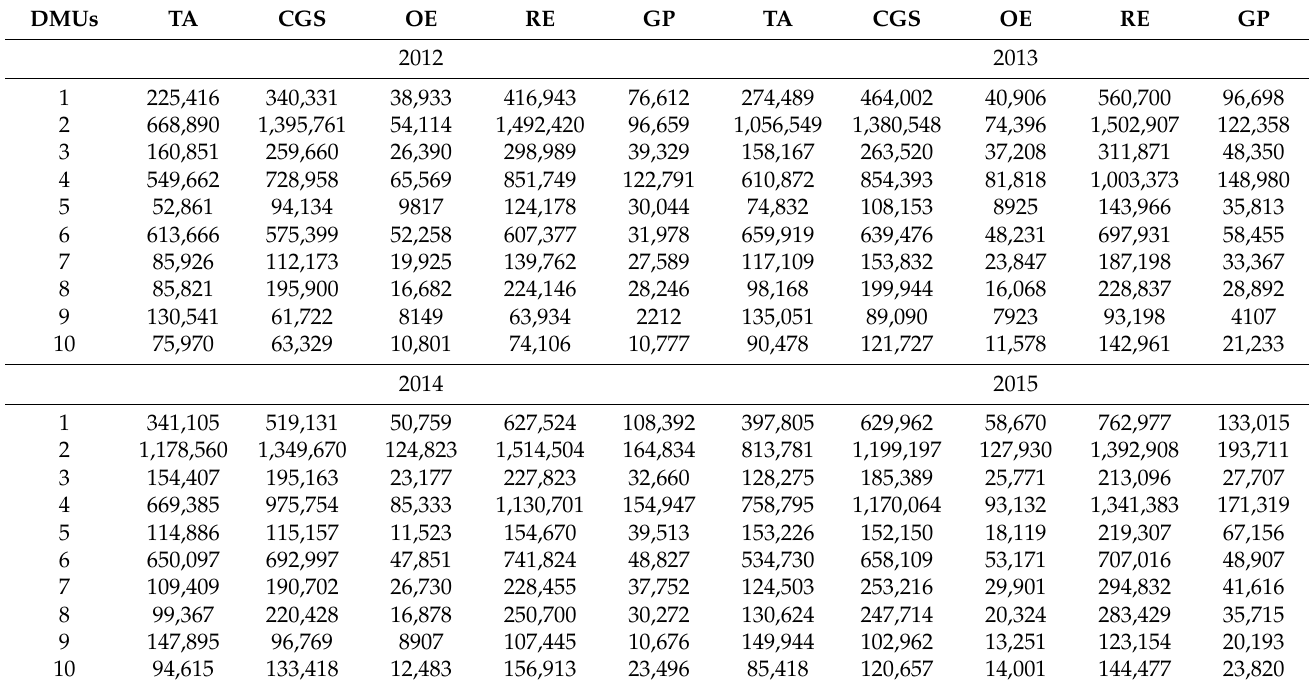
Table A1. Historical data of all DMUs from 2012 to